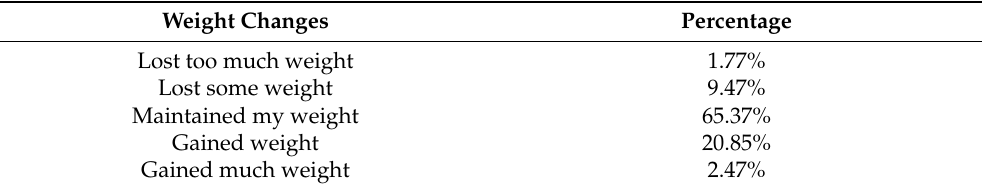
Table 5. Overall weight